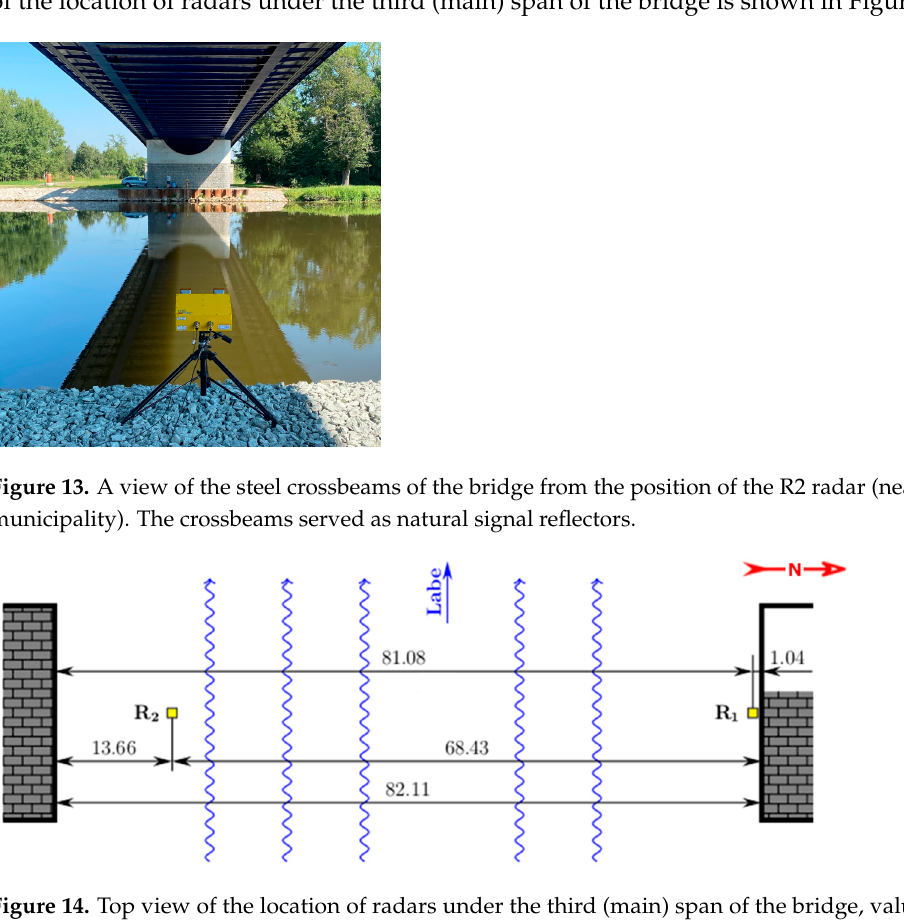
Figure 14. Top view of the location of radars under the third (main) span of the bridge, values are in meters.